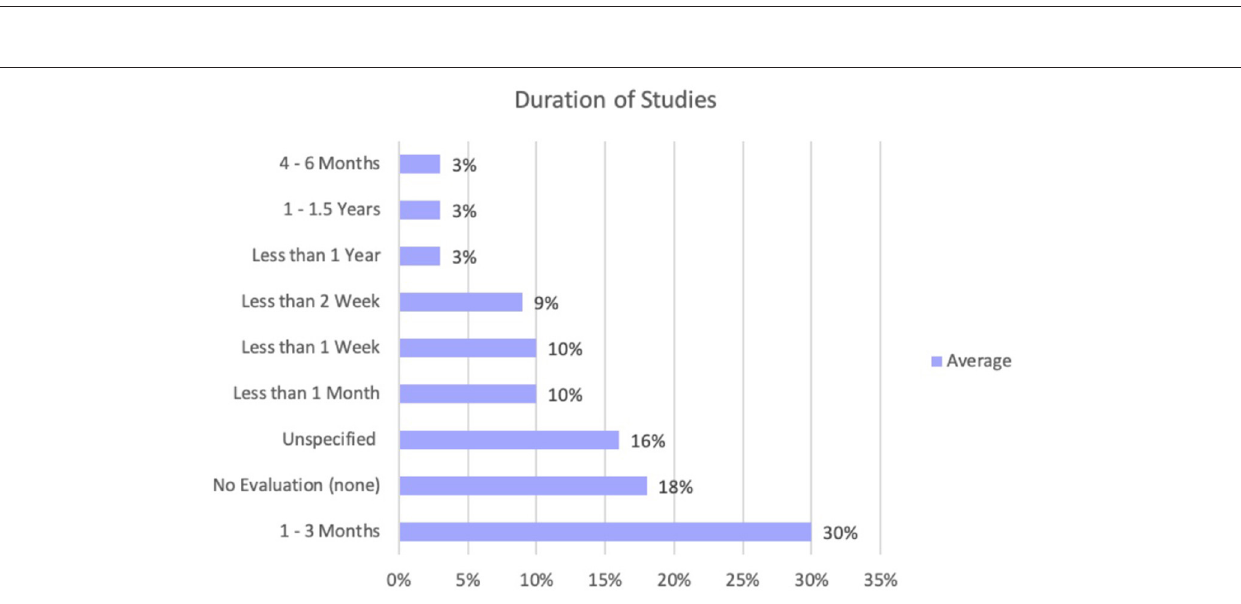
FIGURE 17 | Audience categorization based on their status/occupation/health conditions.